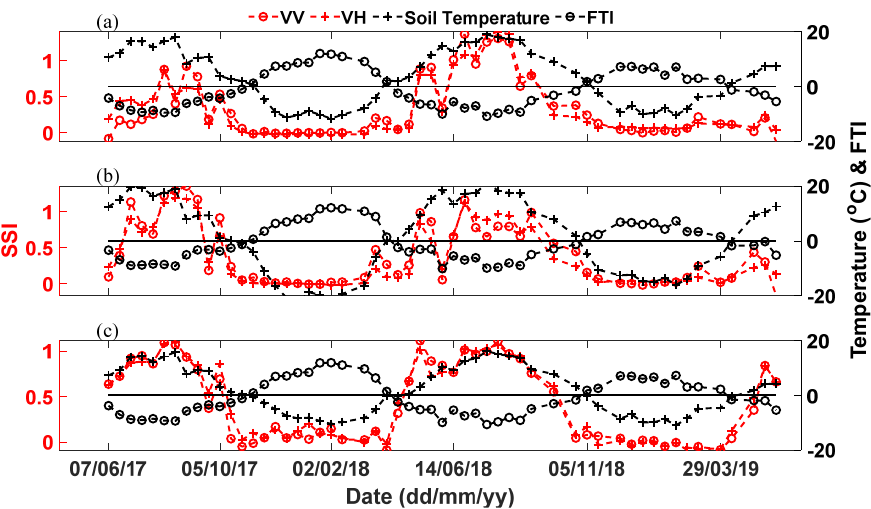
Figure 4. An example of time series of satellite SSI S1 , FTI, and in situ soil temperature for cultivated land (( a ), site 11), grassland (( b ), site 18), and forest (( c ), site 2) over the Genhe watershed. Red line with red circle and red plus symbol are the SSI at VV and VH polarization, respectively. Black line with black circle and black plus symbol are the soil temperature and FTI, respectively.